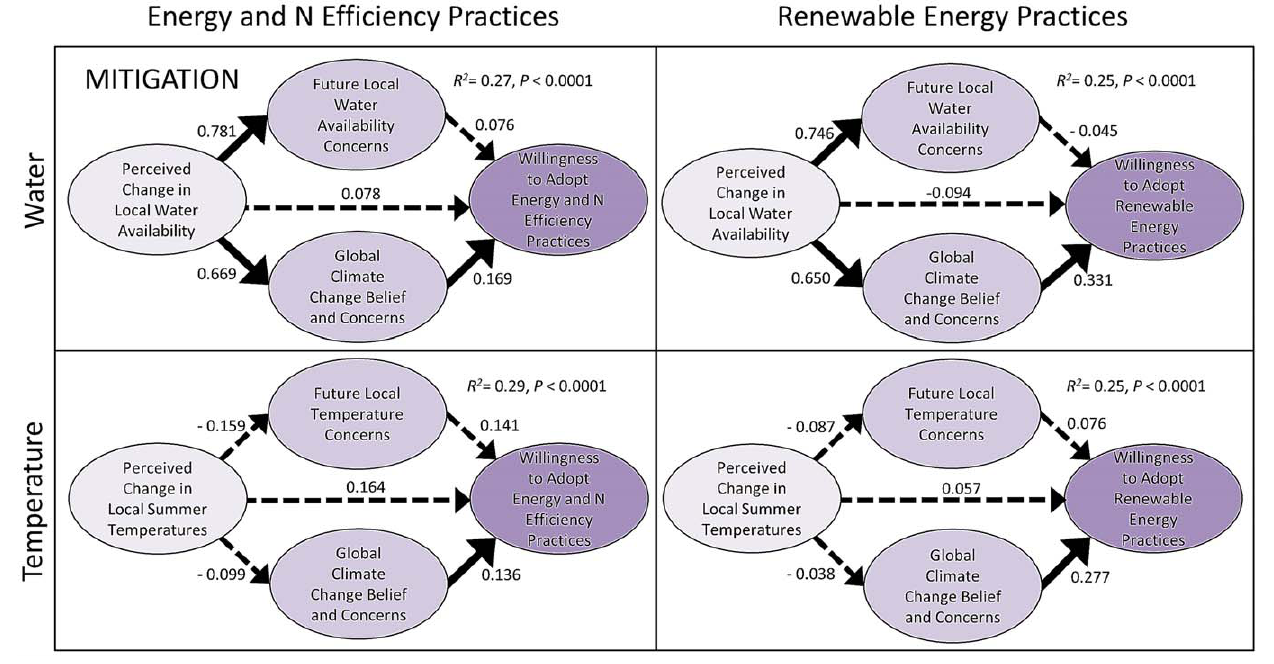
Figure 2. Multiple-mediation models examining the direct and indirect effects of perceived change in local climate (water, temperature) on farmers’ willingness to adopt climate change mitigation practices. Values provided are unstandardized b coefficients indicating the strength of the relationship between variables. Solid arrows represent a significant effect between variables in the pathway (P # 0.05), while broken arrows indicate no significant effect. Overall R 2 and P values associated with prediction of dependent variables are listed for each model.